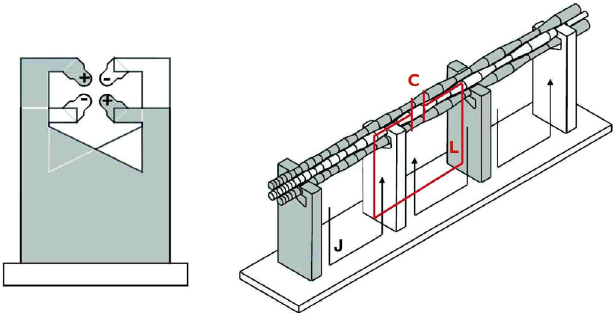
FIG. 3 (color online). This is a cartoon of a four-rod RFQ that has three tuning cells. Each tuning cell can be modeled as an LC circuit with a current J flowing in each cell. Notice that the stems alternatively hold two rods, i.e. the shaded stems hold the shaded rods, while the unshaded stems hold the unshaded rods. The end view of the rod-stem setup shows the quadrupole voltage polarity structure that arises when the currents flow in opposite directions in adjacent tuning cells. This is the necessary quadrupole polarity structure that is required for transverse